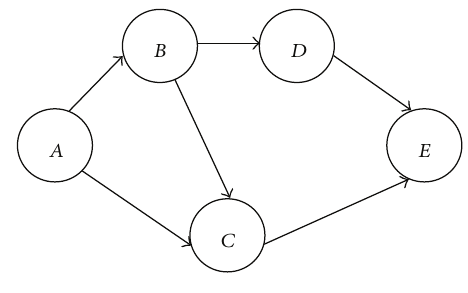
Figure 1: Trust computation.